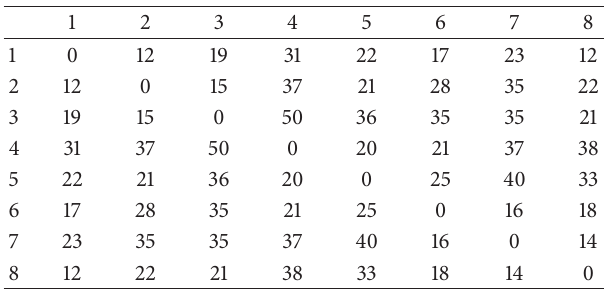
Table 1: Distance matrix for